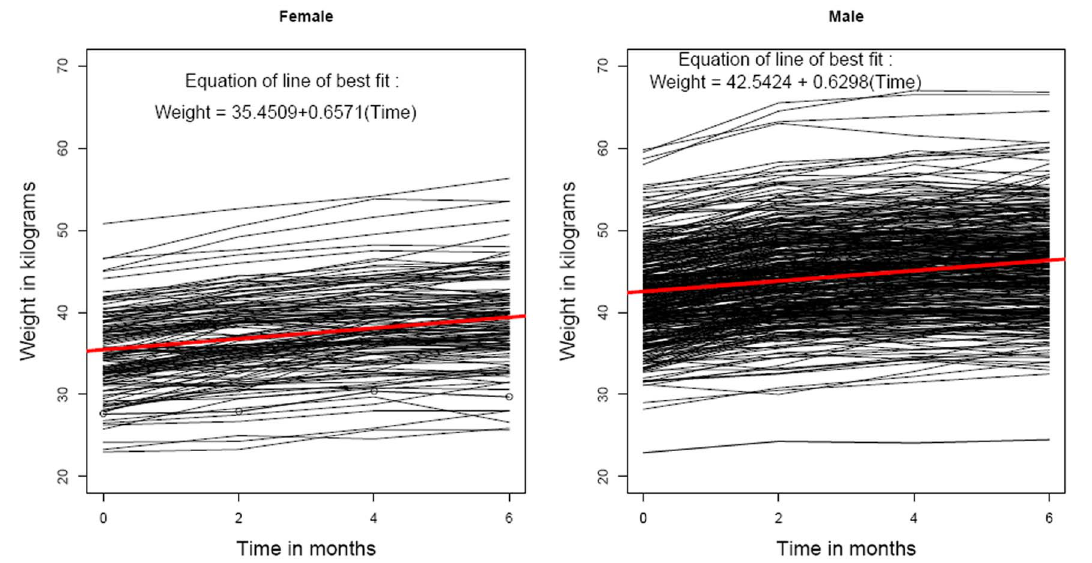
Figure 1. Scatter line diagram of weight of TB patients (in kilograms) versus time (in months) according to gender. Legend: Black lines - weight of TB patients. Red line - line of linear regression.